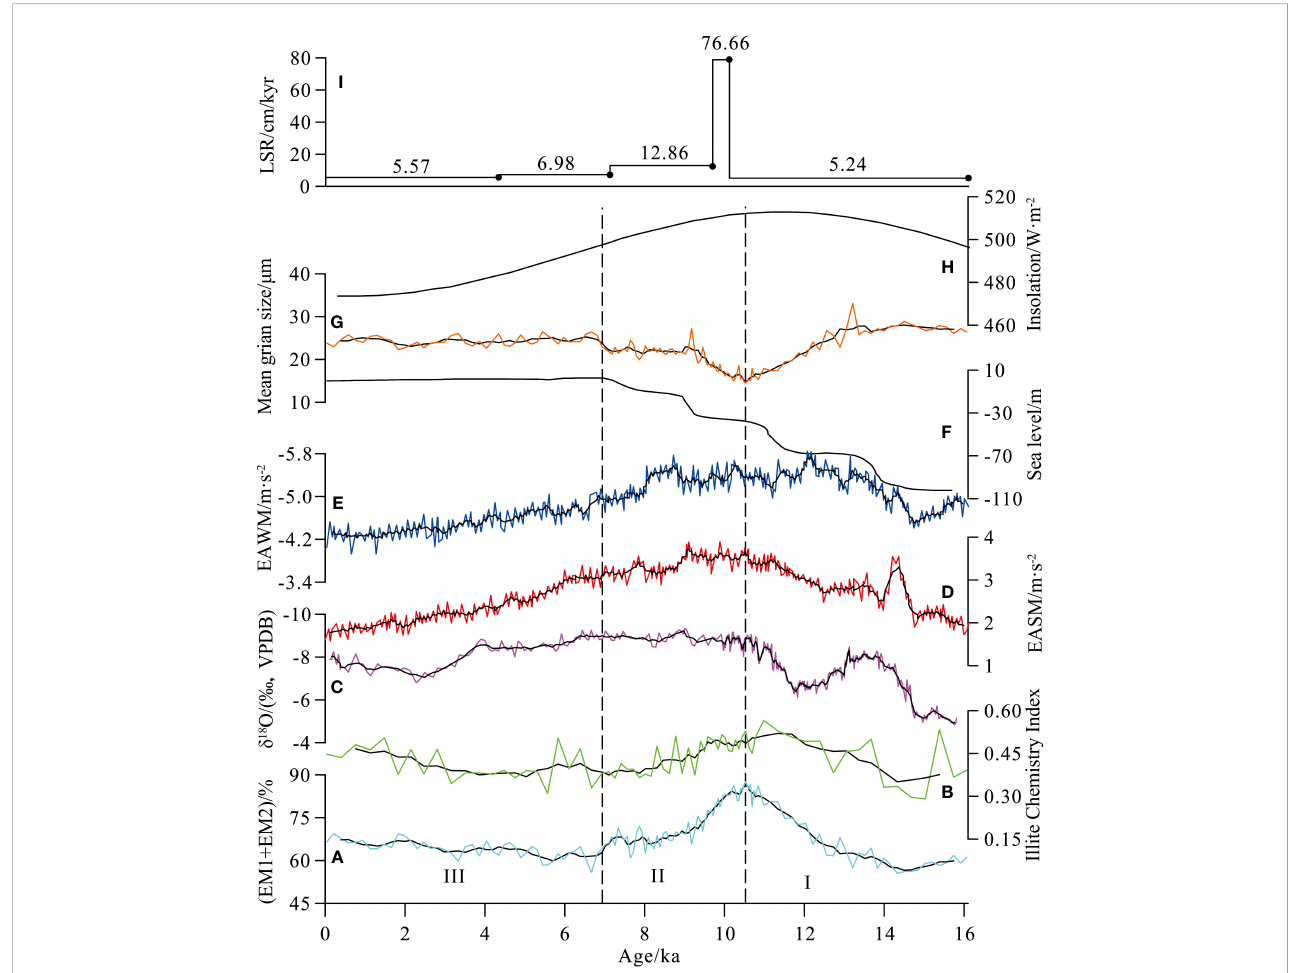
FIGURE 8 Temporal variations in (A) EM1+EM2 in core SCS18-1, (B) illite chemistry index in core SCS18-1, (C) d 18 O values of Dongge Cave stalagmites (Yuan et al., 2004), (D) EASM wind indices in TRACE21 (Wen et al., 2016), (E) EAWM wind indices in TRACE21 (Wen et al., 2016), (F) sea level (Liu et al., 2004;